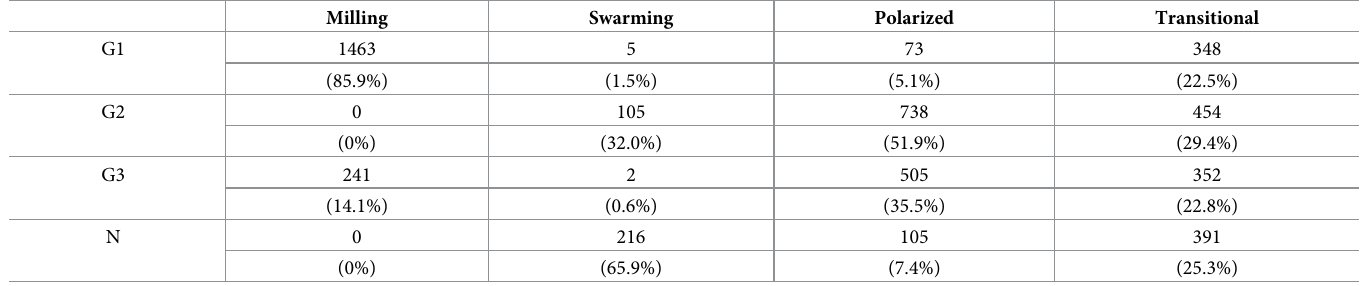
Table 2. Counts of classifications by our map alignment-based statistics (rows) and by the macro-scale variable classification (columns) for the 5000 frames of fish movement data. The percentage of the frames of a given state (milling, polarized, etc.) which is found in each of our unsupervised groups (G1, G2, G3, N) are displayed below the